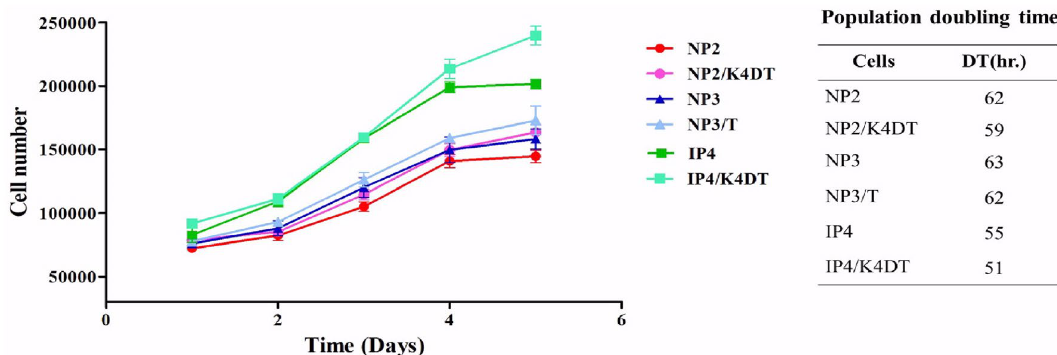
Figure 2. Growth curves and population doubling time (DT) of NP2, NP3, and IP4 cells and their derivatives. Viable cells of the triplicate wells were counted every 24 h for 5 days as described in the Methods, and the mean and the SD were plotted (left panel). Population doubling time was calculated during the exponential growth phase as described in Methods (right). Note that IP4 and IP4/K4DT cells derived from an inverted papilloma showed a faster proliferation rate than NP2, NP2K4DT, NP3, and NP3/T cells derived from nasal polyp cells ( p = 0.0227). DT; population doubling time.